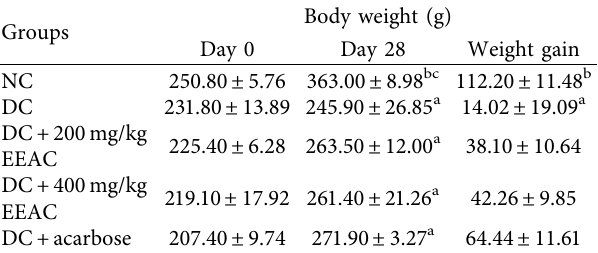
Figure 1: Calibration curve. Table 2: Body weight of experimental animals after 28 days oral administration of EEAC from antidiabetic activity study.